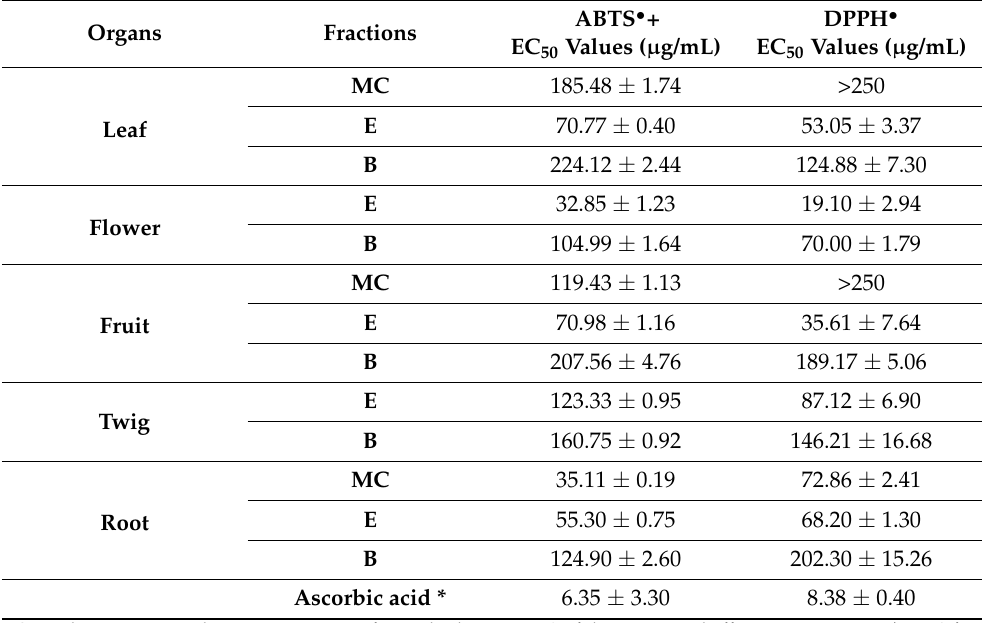
Table 2. Antioxidant properties of active fractions derived from five organs of V. rotundifolia